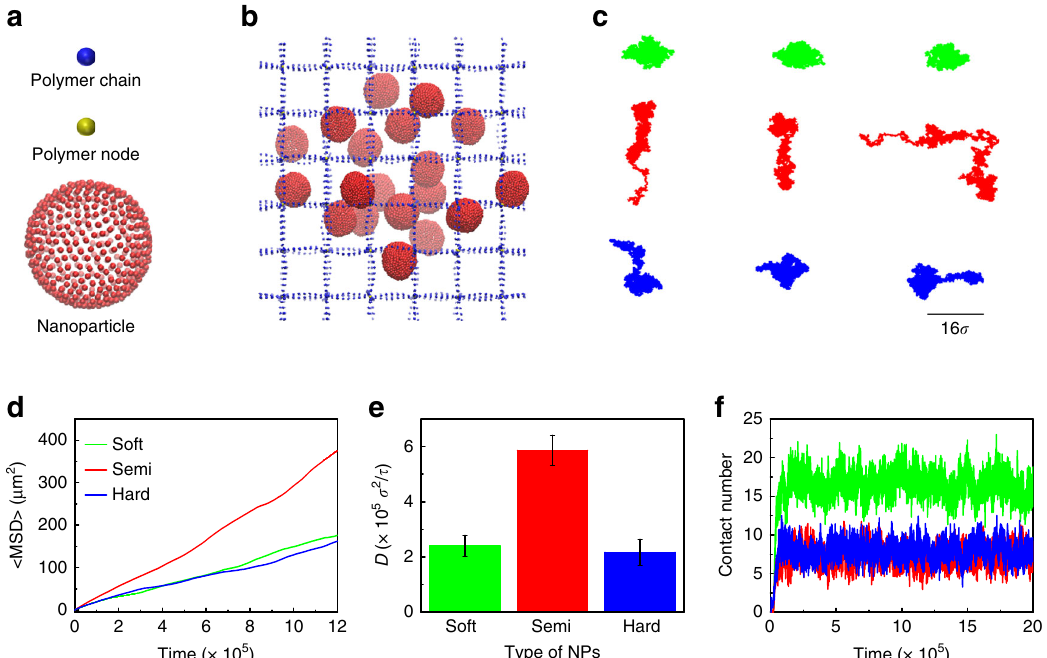
Fig. 7 Snapshots and trajectories of NPs in mucus fi bers. a The original construction of NP. b A snapshot of the polymer network (blue and yellow) and NPs during the simulation. c Typical centroid trajectories of NPs in simulations. d The representative MSD values of the three types of NP in a polymer network with a mesh size of 16 σ . e The diffusivities of NPs in the polymer network. Data are shown as the means ± standard deviations (SDs). ( n = 3). f The number of beads in each NP that came into contact with the polymer network. The blue, red, and green labels represent hard, semi-elastic, and soft NPs,